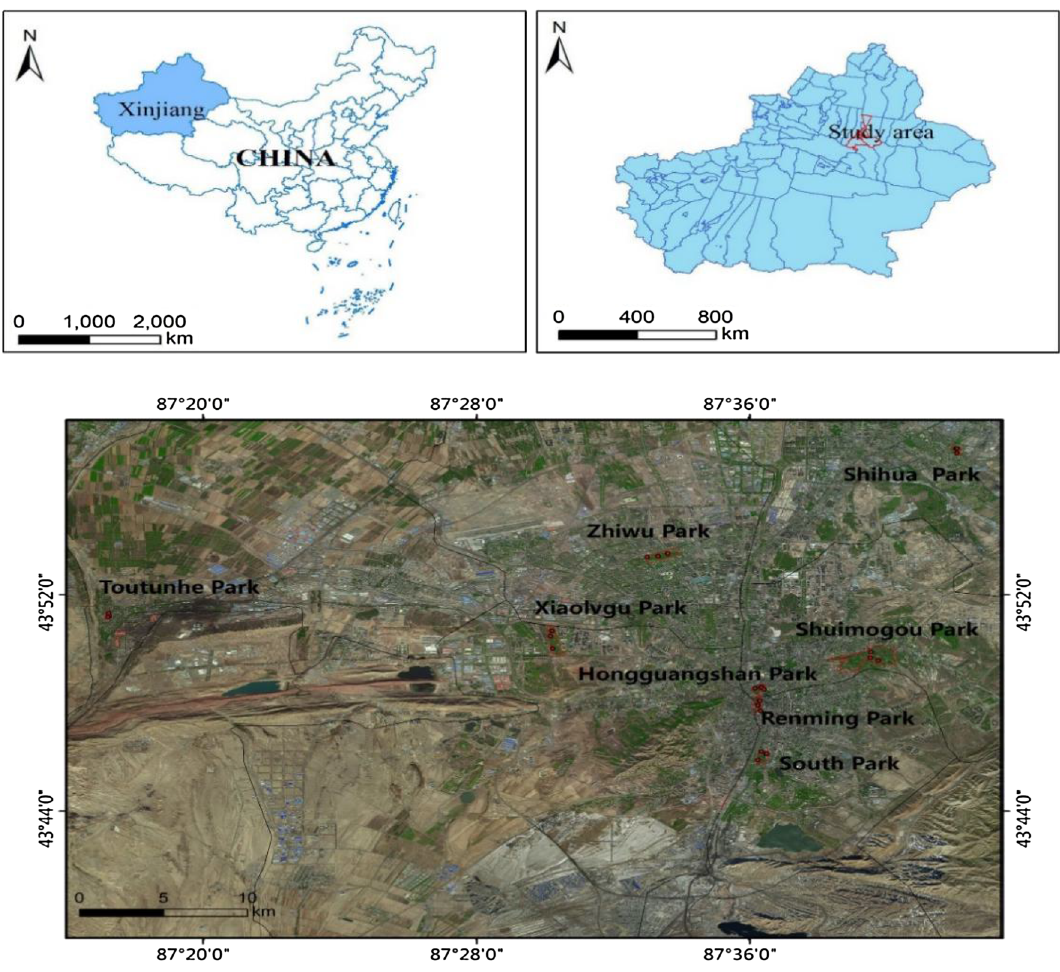
Figure 7. Map of sampling sites in parks in Urumqiy (The ArcGIS 10.8 was used to create the geographic map of the study area, URL: http:// 36. 112. 130. 153: 7777/ DSSPl atform/ index.